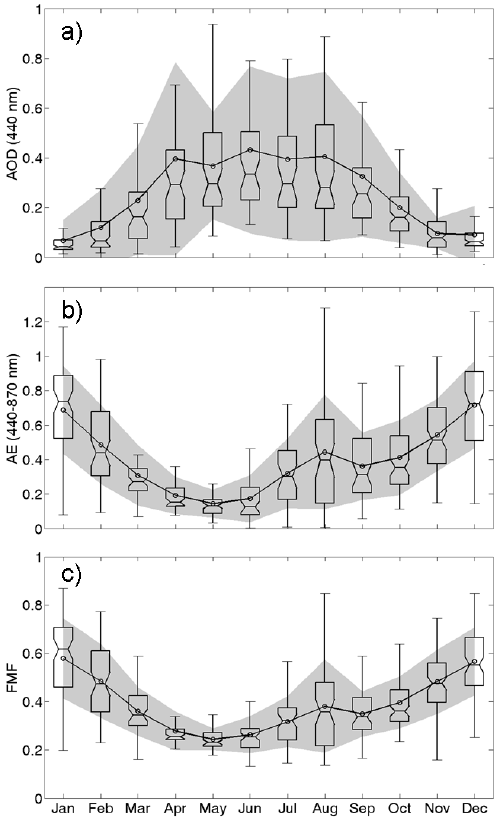
Figure 3. Monthly box-and-whisker plot of daily (a) AOD at 440nm, (b) AE in the range 440–870nm, and (c) FMF at 500nm for the study period at Tamanrasset. Open dots are mean values; grey shaded area indicates the range of values between the mean plus or minus the standard deviation; boxes show 25th, median and 75th percentiles; and whiskers extend from each end of the box to the most extreme values within 1.5 times the interquartile range. AOD, AE and FMF are dimensionless